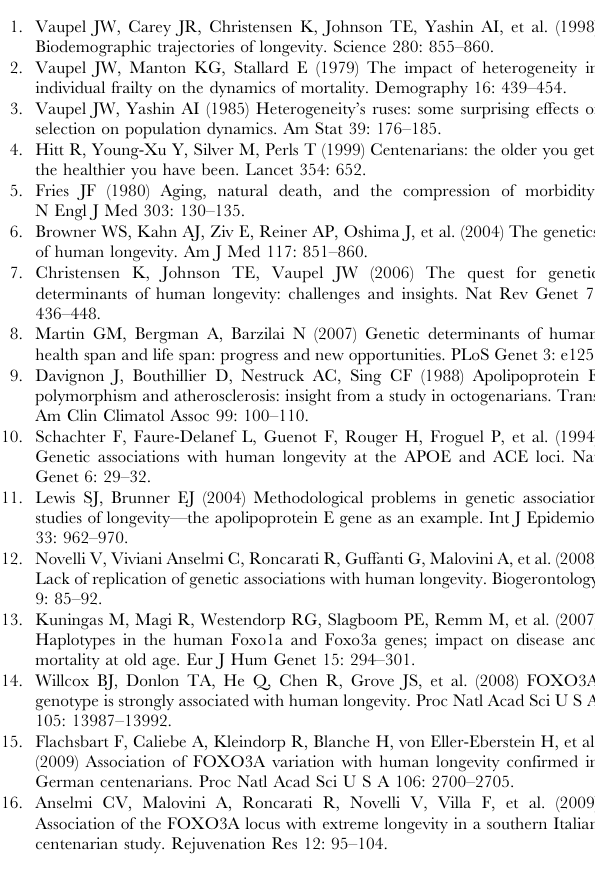
Table S1 Subject characteristics by age category for four subgroups, plus parametric analysis settings. Age, gender, and sibship composition statistics for the Previous, New, MC, and FO subgroups, plus parametric linkage parameters for all groups, are given across ten categories defined by gender-specific minimum requirements for expected age at death. The designations 2-ship, 3-ship, 4-ship, and 5-ship refer to sibships with two, three, four, or five siblings,